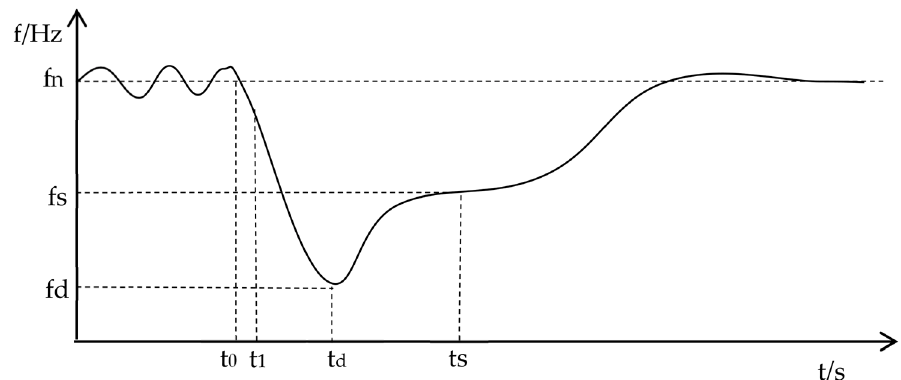
Figure 2. Schematic Diagram of System Frequency Response Process.